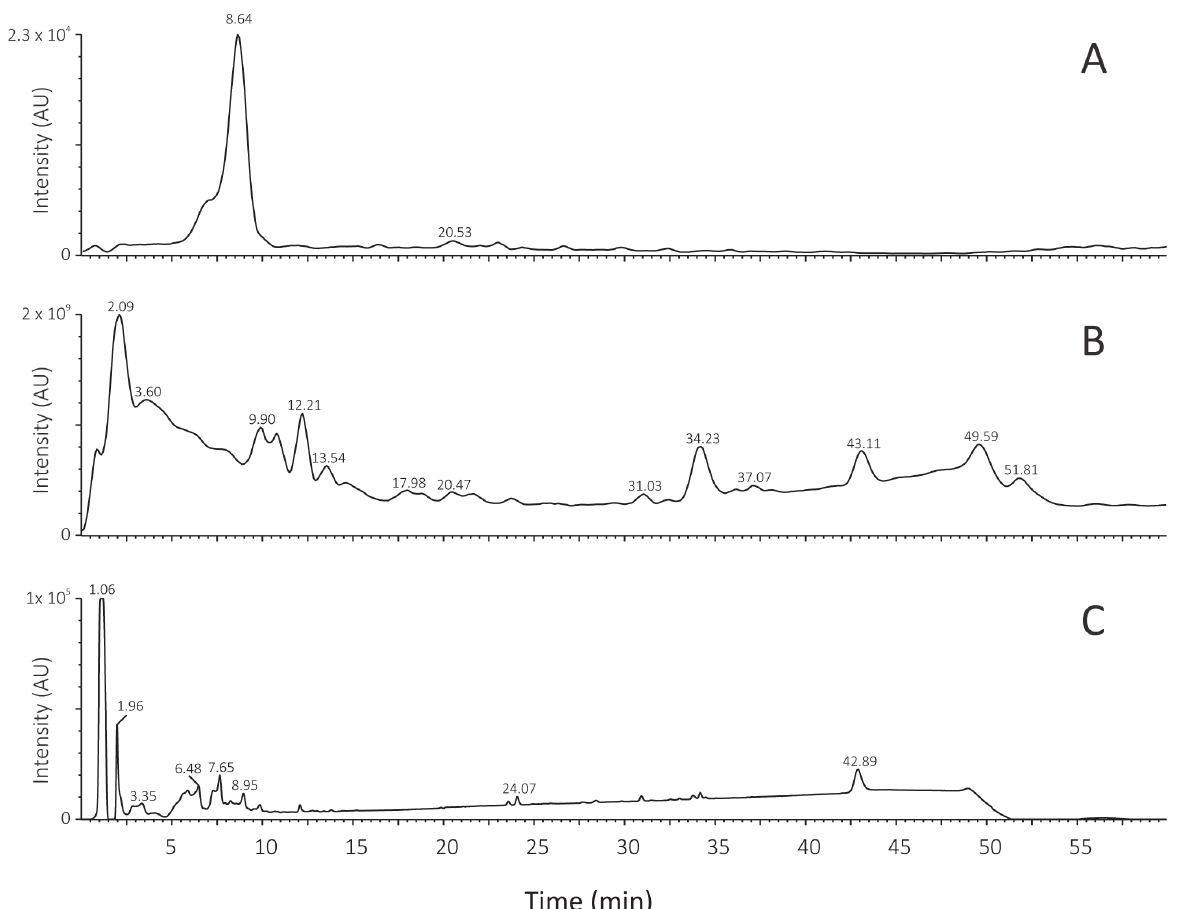
Figure 4 - HPLC/MS/MS analysis of the lyophilized coconut water (LCW). It was analyzed 150 µL of a methanolic solution (MeOH 50%) 75 mg/mL in column Luna C18 150 x 3 mm 5 µm particular size, under 20 °C, flow 0.6 mL/min and using as mobile phase (A) Acetic acid 0,1% and (B) ACN with 0,1% acetic acid. The total flow (0.6 mL/min) was divided by splitter, going to mass spectrometry 0.135 mL/min. A - monitoring of the m/z = 181 → 163; B - Total scan to ESP + ; C - chromatogram in 320 nm. Parameters of the mass spectrometer: Source temperature 100 °C; Desolvation temperature 150 °C; Capillary voltage 2.5 kV; Cone voltage 25 V, Collision energy 15